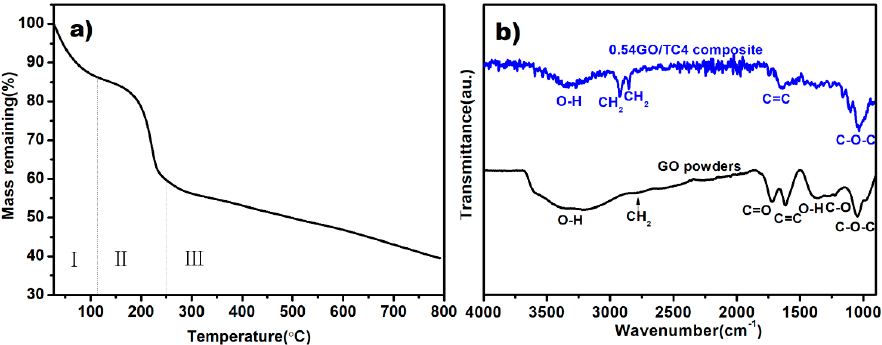
Figure 2. ( a ) TGA plot of the as-received GO powders, and ( b ) FT-IR spectra of as-re- powders and as-sintered GO/TC4 ceived GO powders and as-sintered GO/TC4 composites.